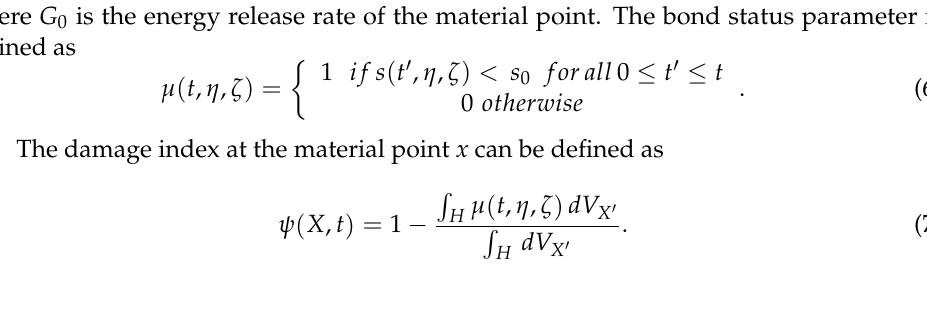
where G 0 is the energy release rate of the material point. The bond status parameter is defined as